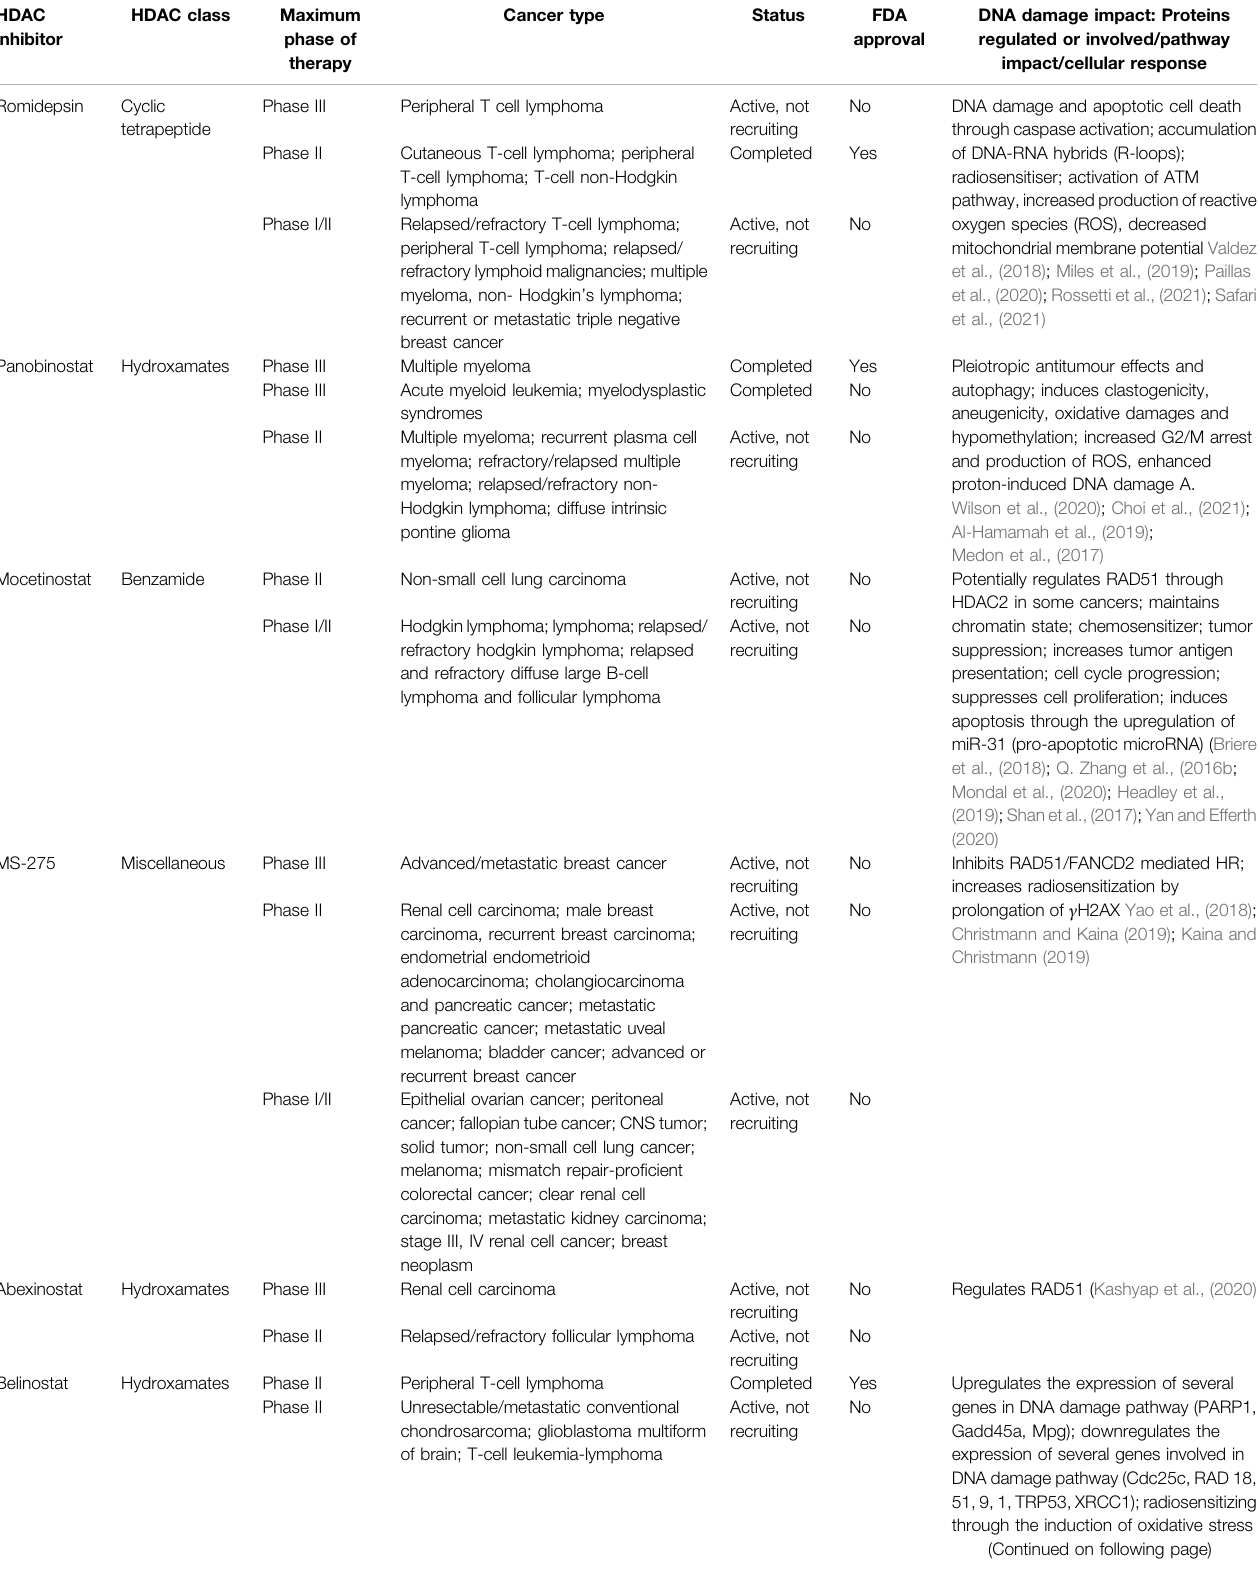
TABLE 1 | Most common clinically used histone deacetylase inhibitors that have been approved by the FDA or are currently undergoing clinical trials for the treatment of